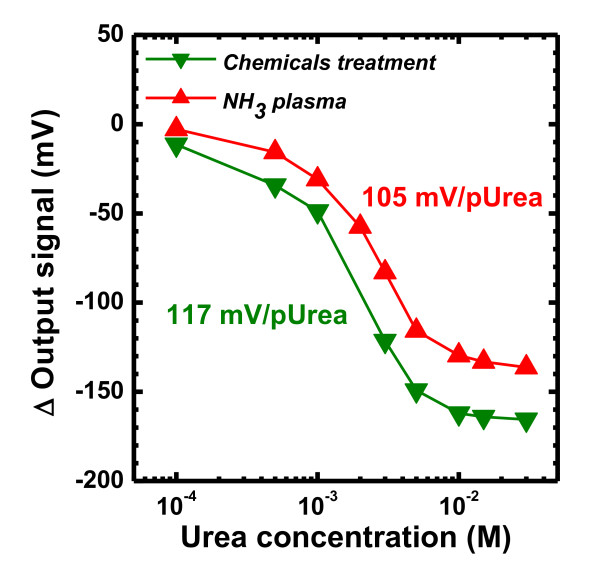
The urea detection of ALD-HfO2-EIS structure with chemical silanization and NH3 plasma treatment.